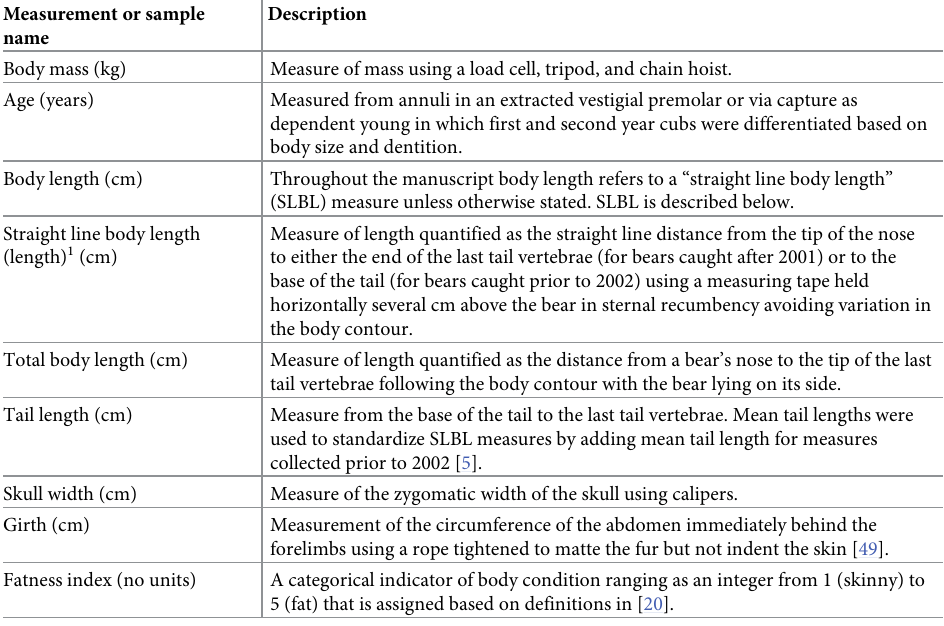
Table 1. Measurements collected from Chukchi Sea and Beaufort Sea polar